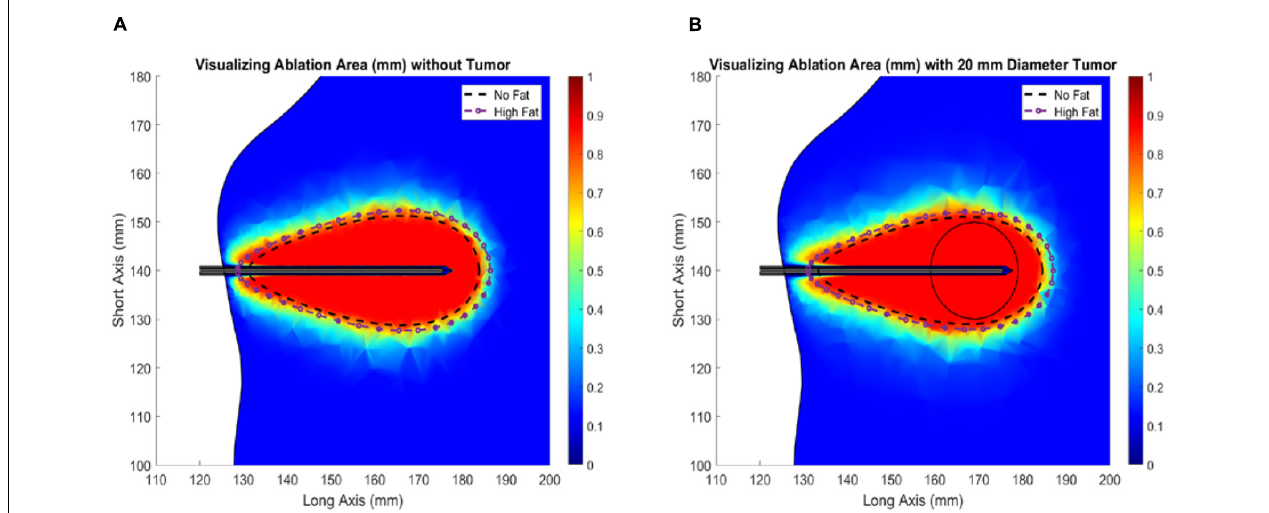
FIGURE 6 | Ablation of liver tissue (915 MHz probe at 60 W of continuous power for 15 min). Ablation margin outlines area where Arrhenius value ( θ d ) ≥ 0.98. The average ideal liver ablation margins are outlined in a dashed black line and the average high-fat (29.9 % liver fat) ablation margins are outlined in a dashed dotted purple line . (A) Liver models without an HCC tumor. (B) Liver models with a 20 mm diameter HCC tumor.